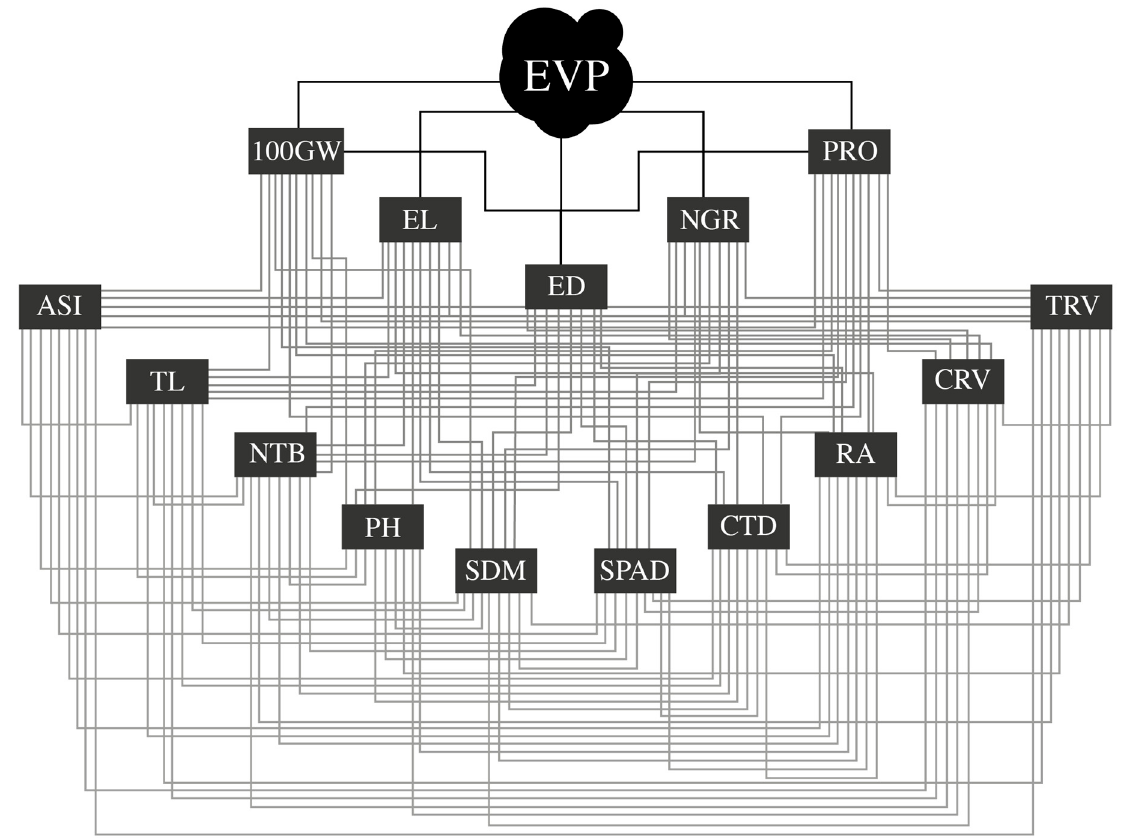
Figure 2. Causal chain graph showing the interrelationship of the main variable expanded popcorn volume per hectare (EPV) with the primary variables—100-grain weight (100GW), ear length (EL), ear diameter (ED), number of grains per row (NGR), and prolificacy (PRO)—and secondary—range between male and female flowering (ASI), tassel length (TL), tassel branch number (NTB), plant height (PH), shoot dry matter (SDM), green index (SPAD), canopy temperature depression (CTD), root angle (RA), crown root volume (CRV) and tap root volume (TRV).